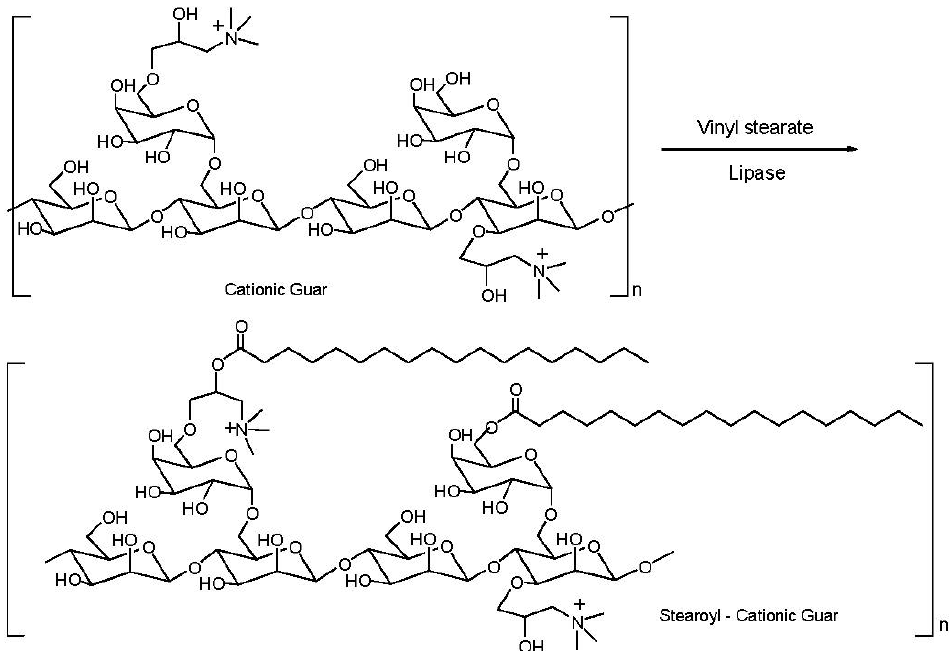
Figure 14. Hydrophobic modification of cationic